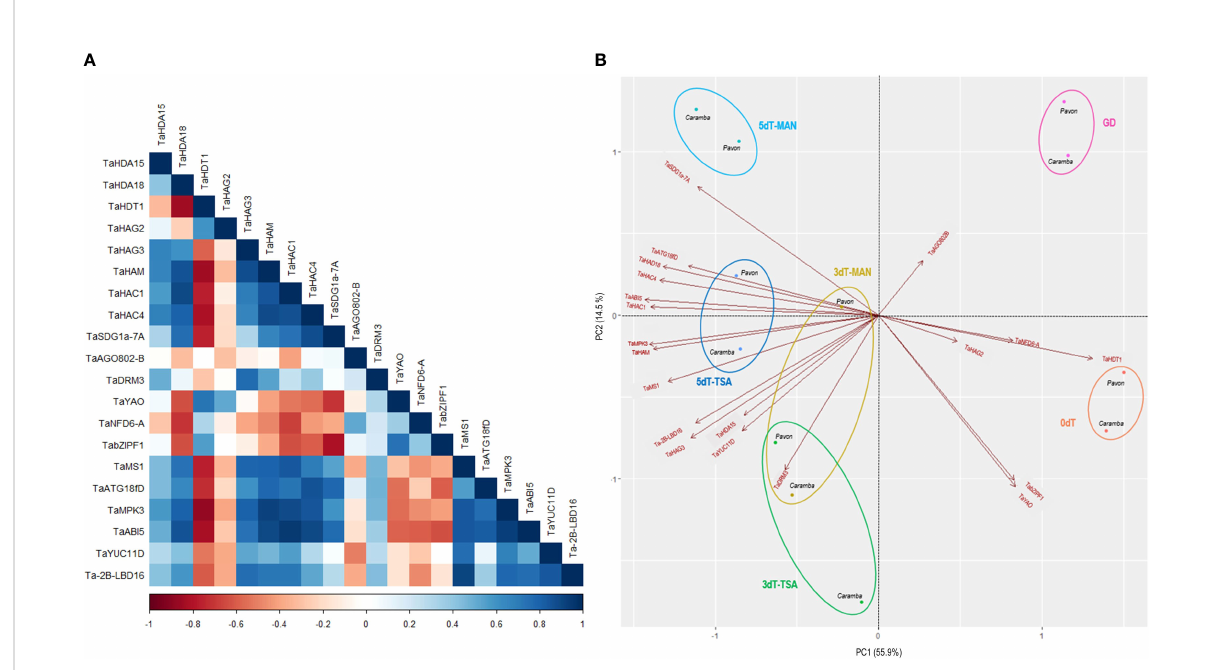
FIGURE 6 (A) Pearson correlation coef fi cients of histone deacetylases, histone acetyltransferases and key genes involved in ME induction, considering all samples of the two cultivars. (B) Principal component analysis (PCA) plot of the 20 genes in Pavon and Caramba. Microspores before stress treatment (0dT), microspores under gametophytic development (GD), microspores after3 and 5 days with mannitol treatment (3dT-MAN, 5dT- MAN) and after 3 and 5 days with mannitol plus TSA treatment (3dT-TSA,